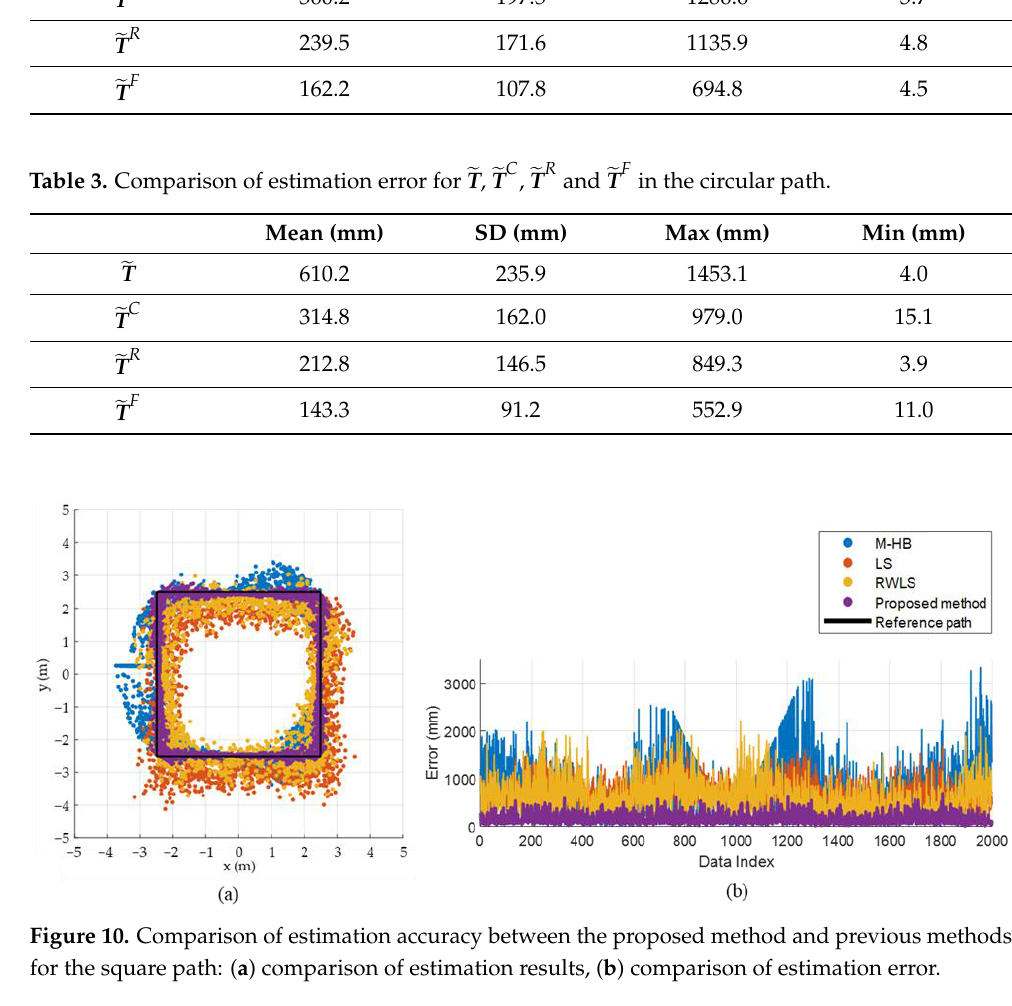
Table 4. Comparison of estimation error between the proposed method and previous methods for the square path.